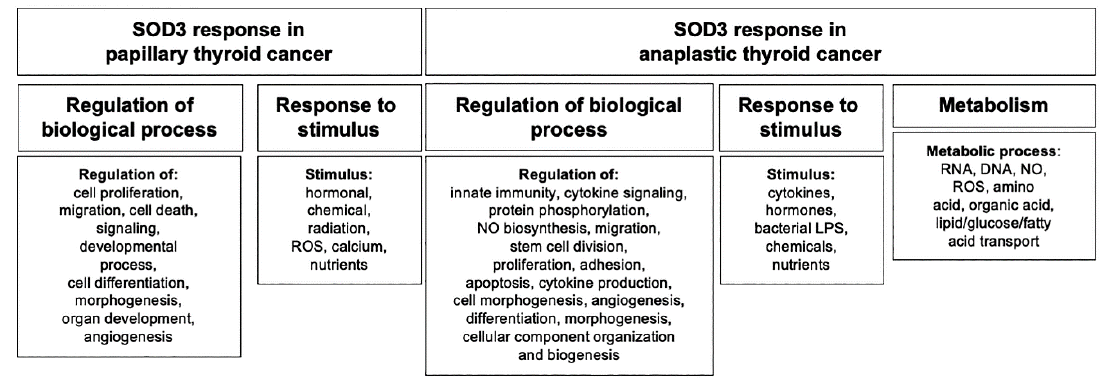
Figure 2. Gene ontology enrichment analysis. The analysis indicated the cancer type specificity for SOD3-driven regulation of the biological pathways. TPC1 cells model papillary thyroid cancer and 8505c cells model anaplastic thyroid cancer. SOD3 affected the expression of a vast number of genes committed to the regulation of biological pathways.